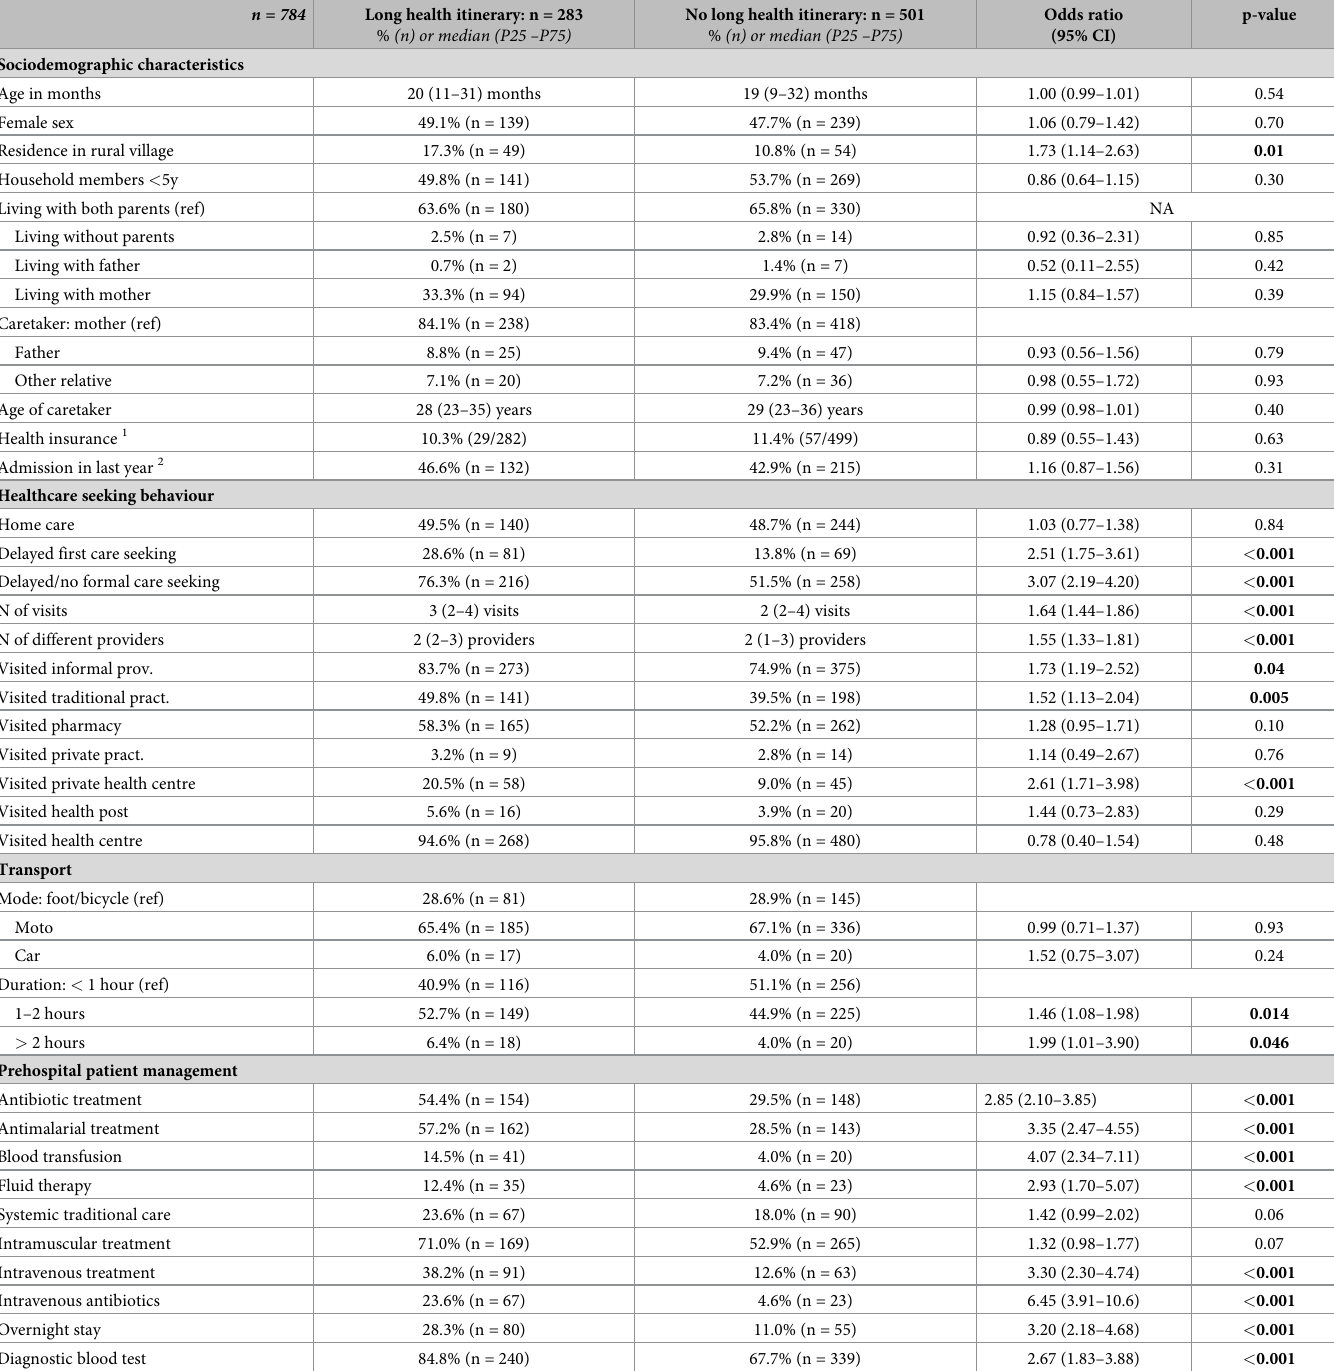
Table 1. Unadjusted association between long health itinerary (admission > 3 days after fever onset) and sociodemographic characteristics or factors from the three-delay model (healthcare seeking, transport and prehospital patient management), calculated by logistic regression. n =